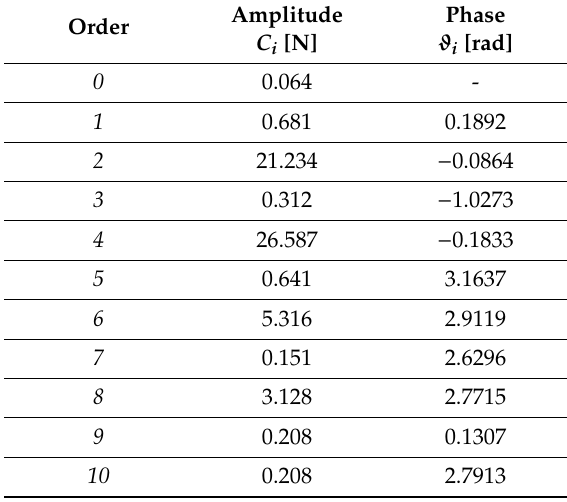
Table 4. Evaluation of Fourier terms until the tenth harmonic in the prototype case. Amplitude Phase Order Order 𝑪 𝒊 [N]